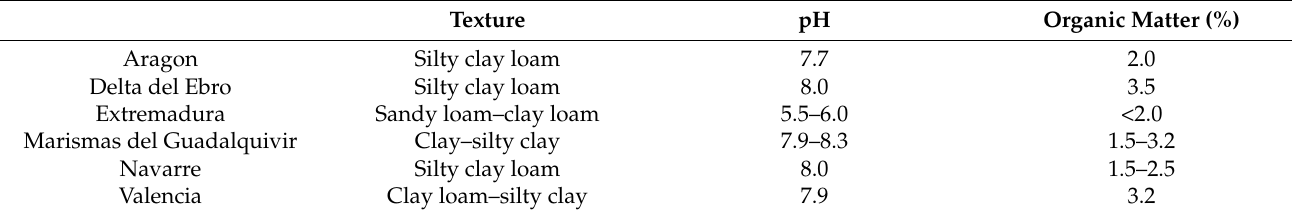
Table 3. The main soil characteristics of the major Spanish rice